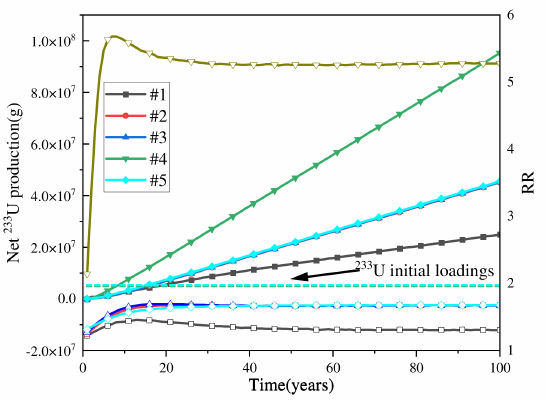
Figure 7. Evolution of net production of 233 U (solid dot lines) and RR (empty dot